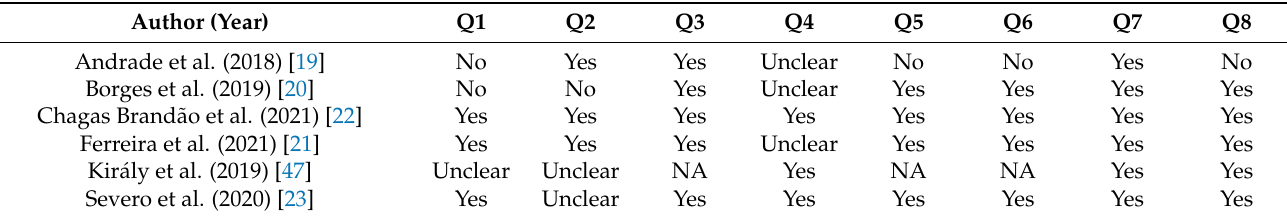
Table 3. Evaluation of the quality of the studies